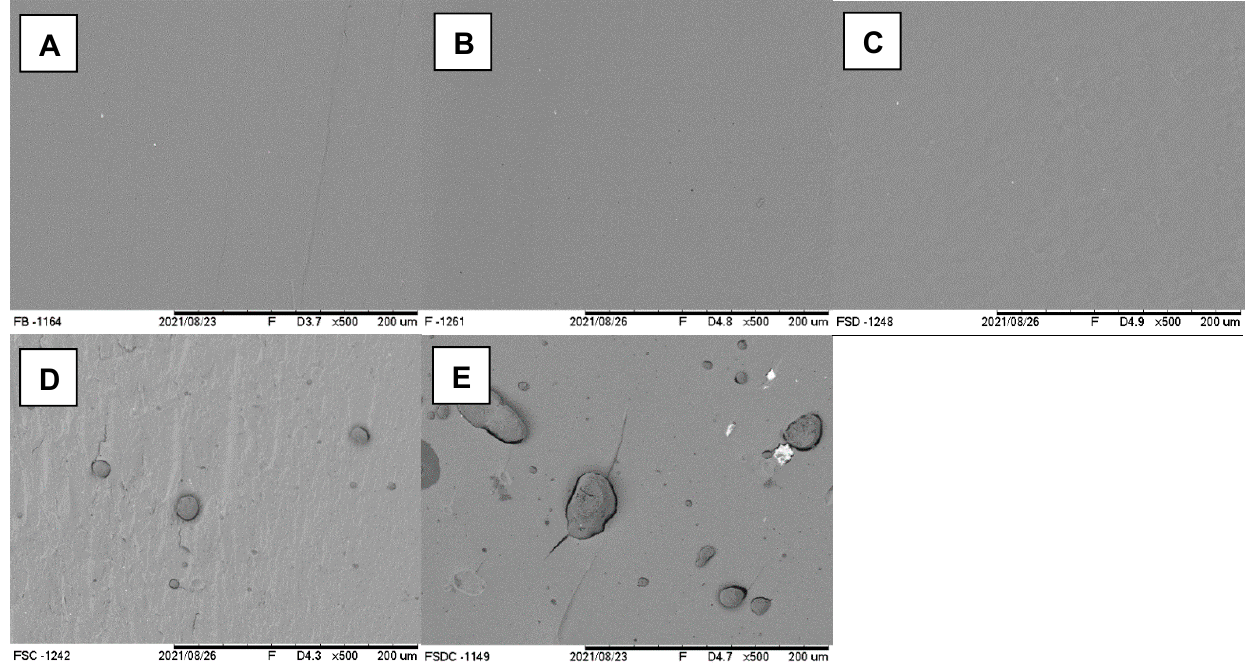
Figure 2. SEM micrographs of the control sheet ( A ), sheets incorporated with non-encapsulated ( B ) and encapsulated tucumã oil ( C – E ; with particles SD, SC and SDC, respectively), at 200× magnifica- tion.